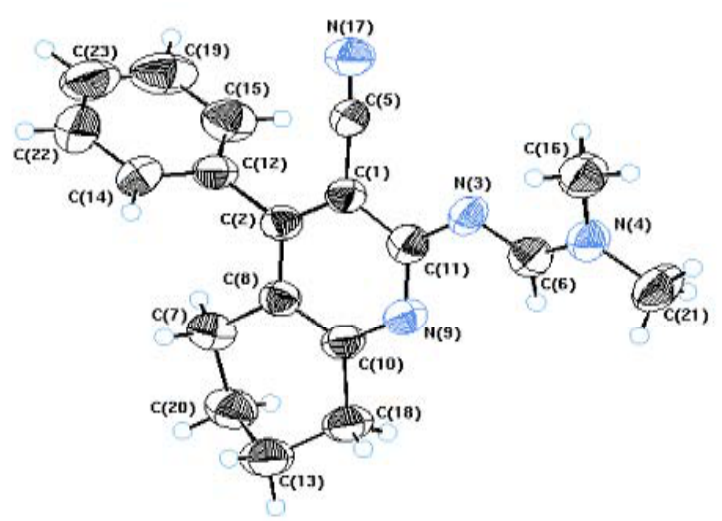
Figure 2. ORTEP diagram of Compound 5 .